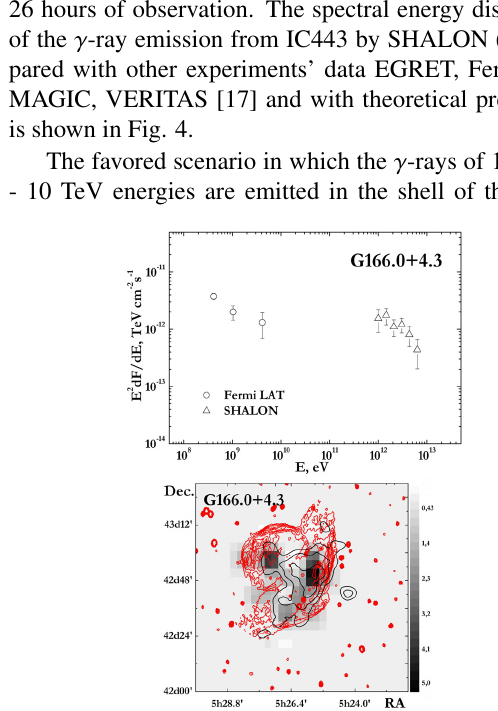
Figure 5. Characteristics of G166.0 + 4.3: top: Spectral energy distribution of high- and very high energy γ -ray emission by SHALON ( ) in comparison with other experiments. bottom: (cid:31) Image of this SNR at energies > 0 . 8 TeV by SHALON (grey scale). Red contours are 1420 MHz radio structure by Canadian Galactic Plane Survey DRAO. Contours levels are 10%, 20% etc 90% of the radio emission map maximum. Black contours are X- ray structure by ROSAT in the energy range 0.52 - 2.02 keV. X- ray contours are logarithmic and correspond to 11%, 19%, 33% and 57% of image